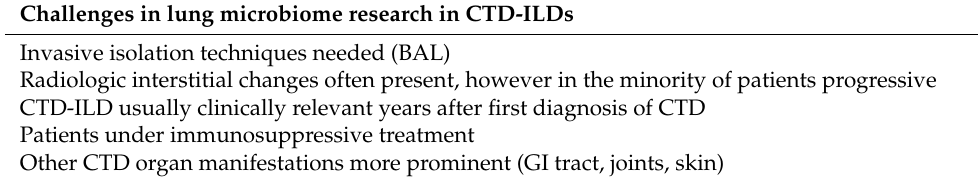
Table 2. Challenges in lung microbiome research in